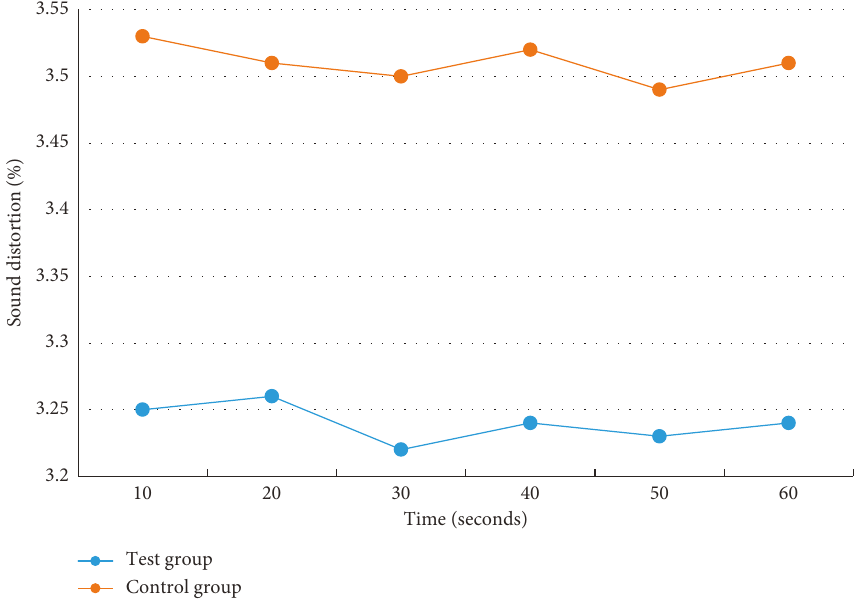
Figure 9: Comparison chart of the error degree of different algorithm system analysis.